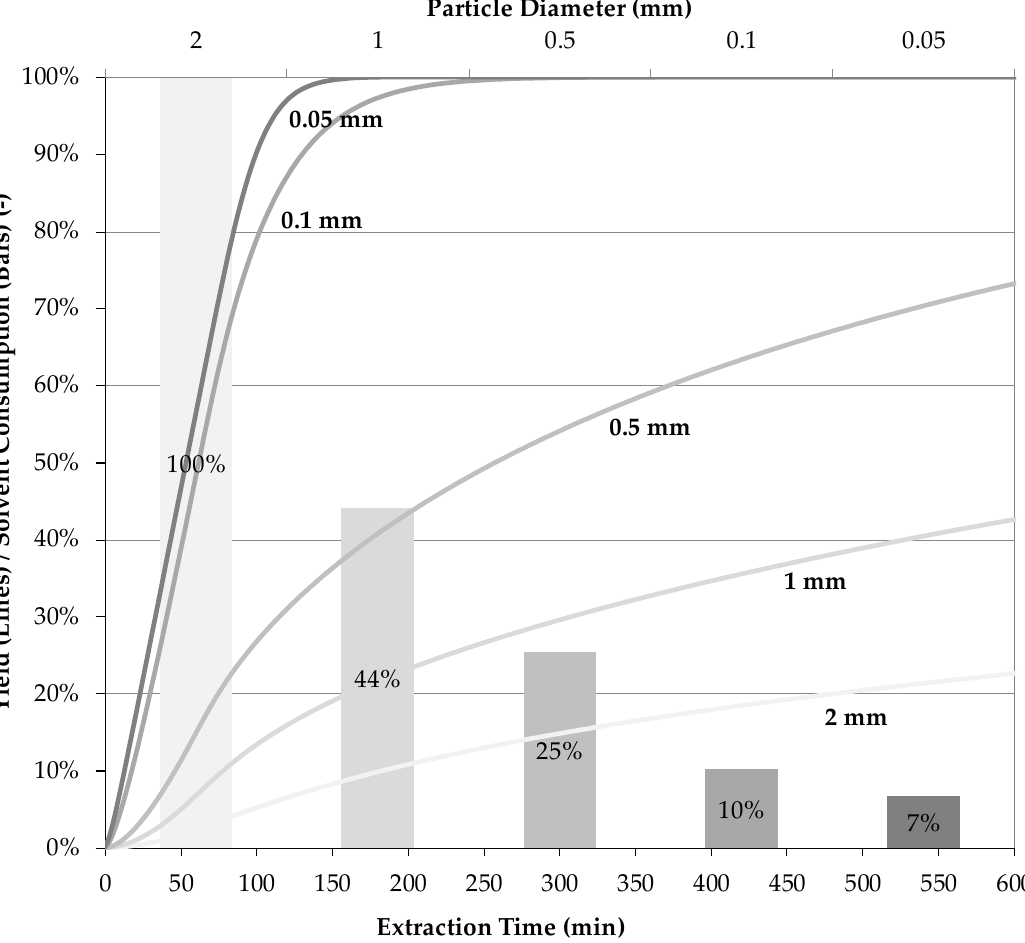
Figure 12. Simulated extraction curves and relative solvent consumptions for different mean particle diameters.